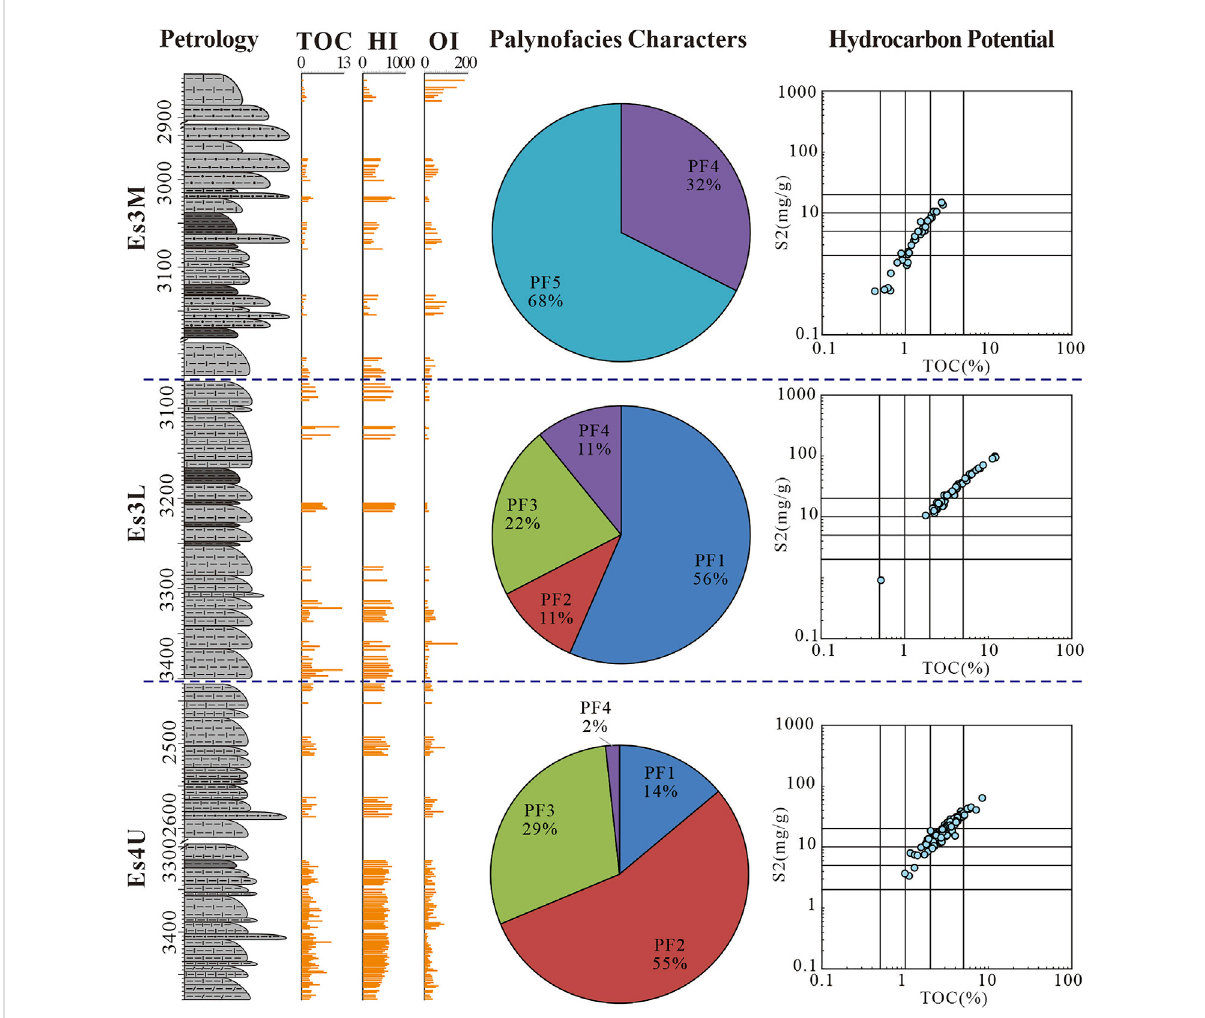
FIGURE 12 Compositehistogramofpyrolysisparameter,palynofaciescompositionandhydrocarbongenerationofthemiddleEs3-upperEs4submeberin the Dongying